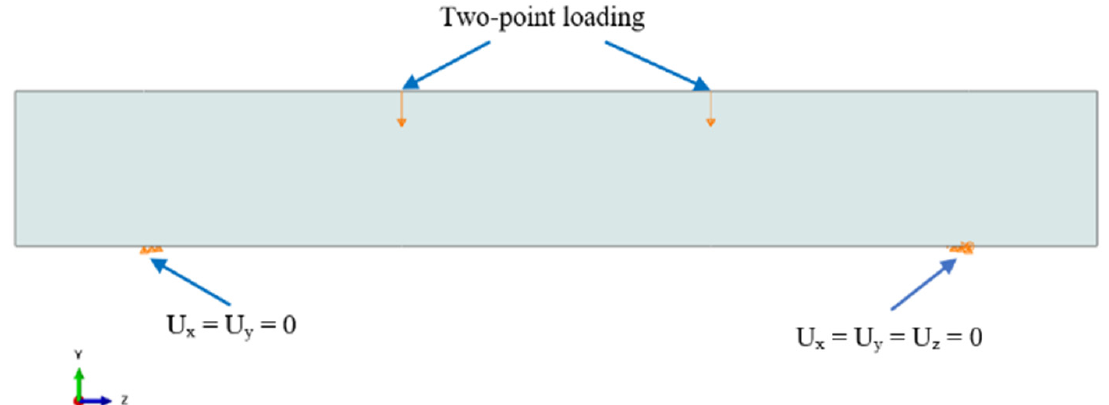
Figure 6. Typical loading and boundary conditions.